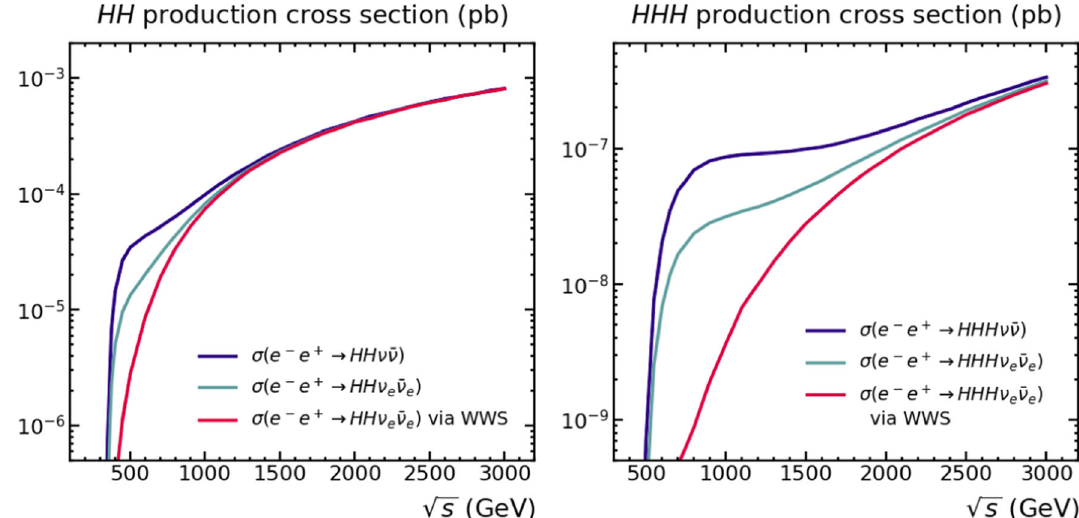
Fig. 4 Double (left) and triple (right) Higgs production cross section in e + e − collisions with neutrinos in the final state and the corresponding contributions coming from H H ( H )ν e ¯ ν e and WWS. The prediction for σ( e + e − → H H ( H )ν e ¯ ν e ) via WWS is defined in Eq. (7)